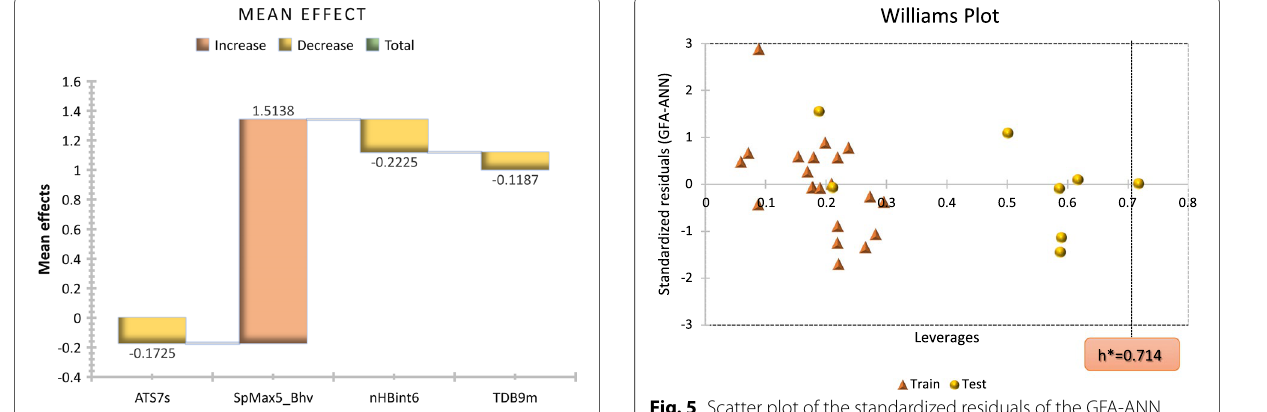
Table 9 Statistical validation results of probable CoMFA